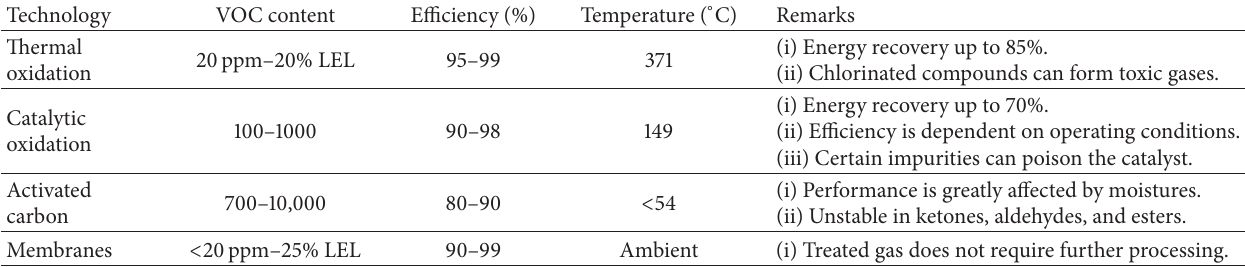
Table 12: Comparison with different technologies for VOCs removal [27, 159,